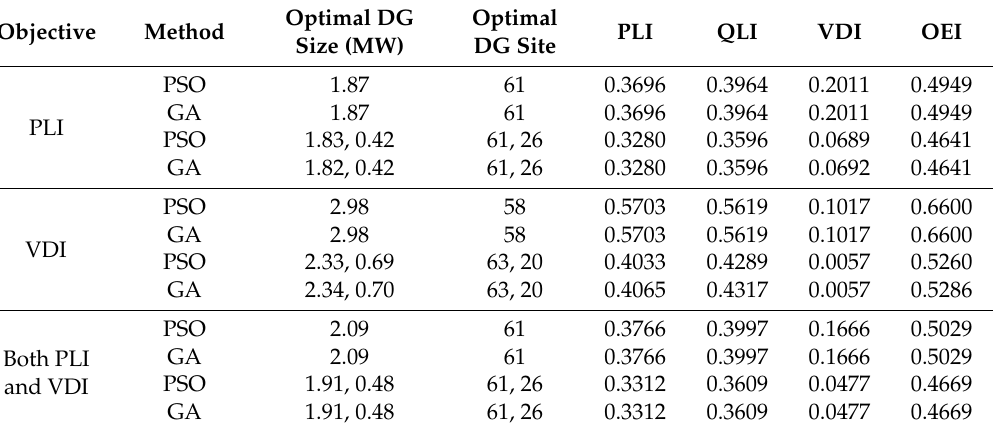
Table 6. Validation of proposed